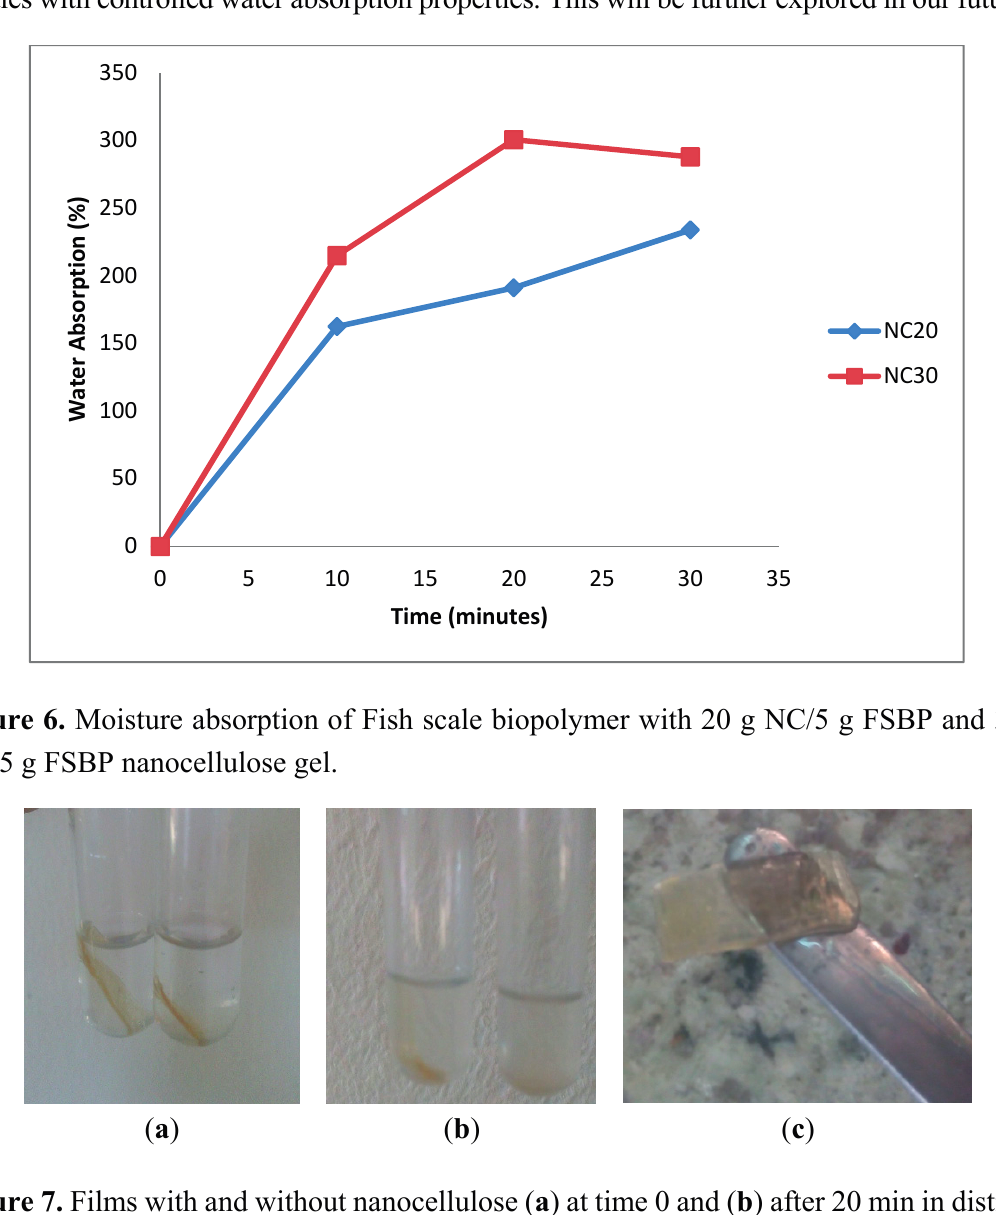
Figure 7. Films with and without nanocellulose ( a ) at time 0 and ( b ) after 20 min in